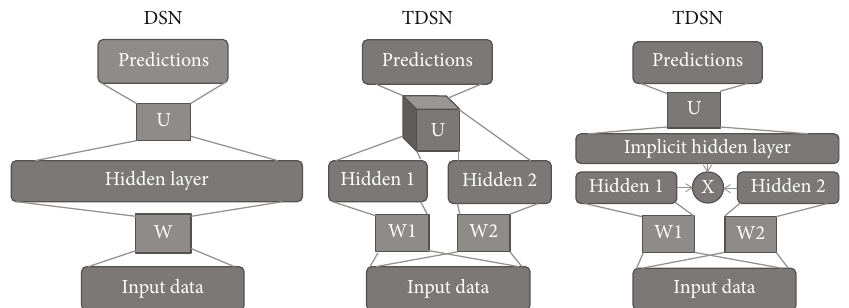
Figure 2: Single module DSN, TDSN, and equivalent TDSN